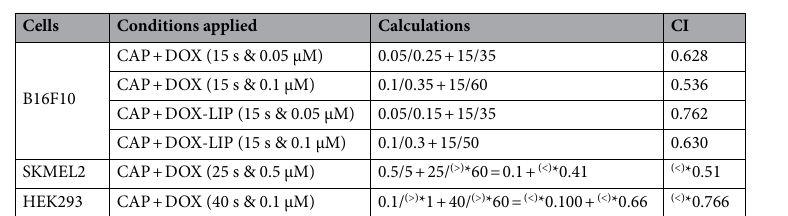
Table 2. Combination Indices/indicators of synergistic effects between DOX (or DOX-LIP) and CAP on cell viability. *Absolute value was not available or could not be